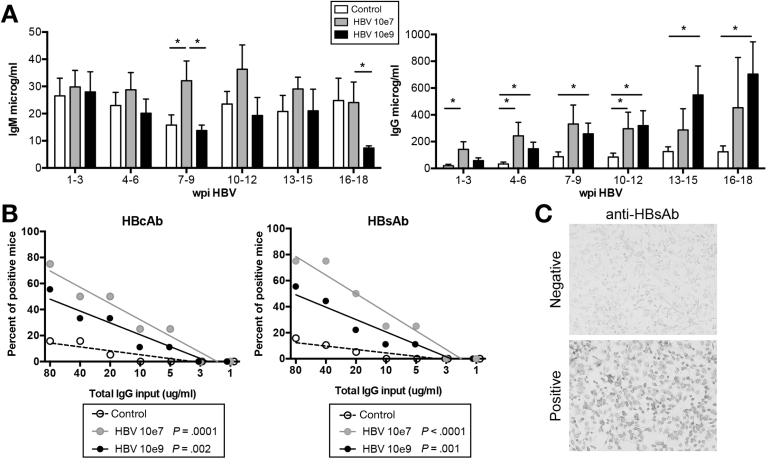
Humoral immune responses in HBV-infected HIS-HUHEP mice. (A) Total human IgM and IgG concentrations in the plasma of HIS-HUHEP control (white bar; n=11) or HBV-infected mice (10e7 inoculum: grey bar; n=5, 10e9 inoculum: black bar, n=9) plotted against weeks post infection (wpi). Bars show the mean with SEM. Statistics used unpaired two-tailed t test. (B) Analysis of anti-HBV antibodies in HIS-HUHEP mice. The frequency of mice positive for HBcAb IgG or HBsAb IgG from serially diluted plasma at the indicated concentration of total human IgG was analyzed by nonlinear regression. HIS-HUHEP control (n=19, dotted line), HBV-inoculated at 10e7 (n=4, grey line) or 10e9 (n=9, black line). P values indicate the differences between the slopes compared with the control data. (C) Representative images of IHC for anti-HBsAb.